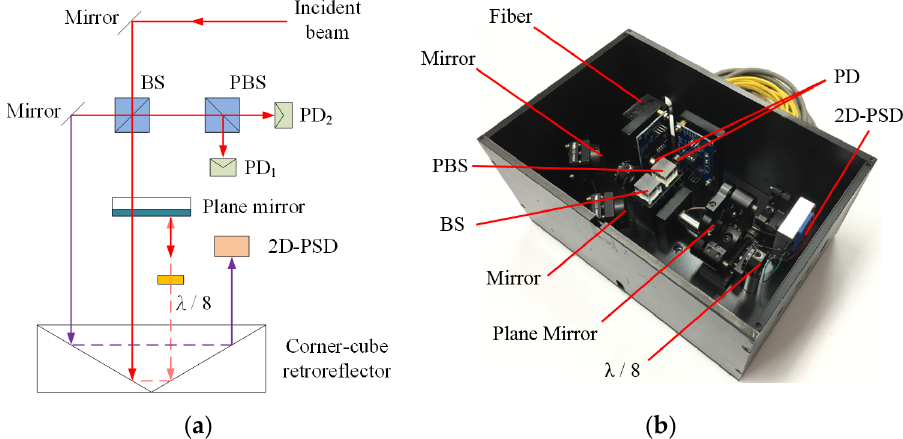
Figure 7. Proposed linear displacement calibration system: ( a ) Optical structure and ( b ) optomechanical structure.